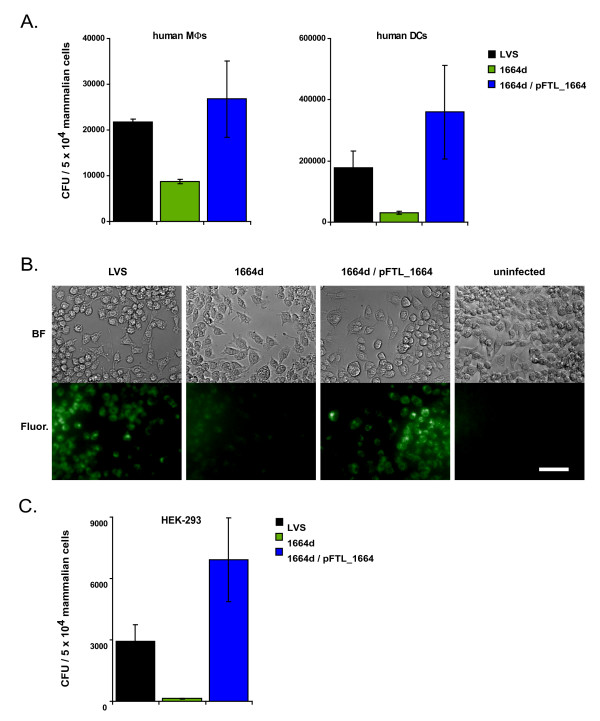
deoB is important for entry of F. tularensis LVS. (A) Primary human macrophages (MΦs) or dendritic cells (DCs) were infected with either LVS, 1664d, or 1664d/pFTL_1664 in microtitre plates. After a two-hour incubation, wells were treated with gentamicin to kill extracellular bacteria, followed by vigorous washing. Subsequently, phagocytic cells were lysed and serial dilutions of lysates were plated for CFU enumeration. Data are mean ± SEM of triplicate wells within one experiment and are representative of four (primary human macrophages) or two experiments (dendritic cells) performed using cells from separate donors. Following log transformation, differences in CFU between LVS and 1664d were determined by a Student's t-Test in which P = 0.00005 and 0.003 for MΦs and DCs, respectively. (B) Bacteria were stained with the fluorescent green stain, Syto-9 prior to infection. After a two-hour incubation with RAW 264.7 cells, extracellular bacteria were washed away and cells were analyzed under brightfield (BF) and fluorescence (Fluor.) microscopy. The exposure time was extended to enhance sensitivity of detecting the low numbers of 1664d within the RAW 264.7 cells, leading to some background fluorescence. Fluorescence images were initially captured in grayscale and pseudocolored using Adobe Photoshop. Data displayed are representative of duplicate experiments. Scale bar = 50 μm. (C) Human embryonic kidney 293 (HEK-293) cells were infected similarly to the phagocytic cells in panel A. Data are mean ± SEM of triplicate wells within one experiment and are representative of three experiments. Following log transformation, differences in CFU between LVS and 1664d were determined by a Student's t-Test in which P = 0.0004.